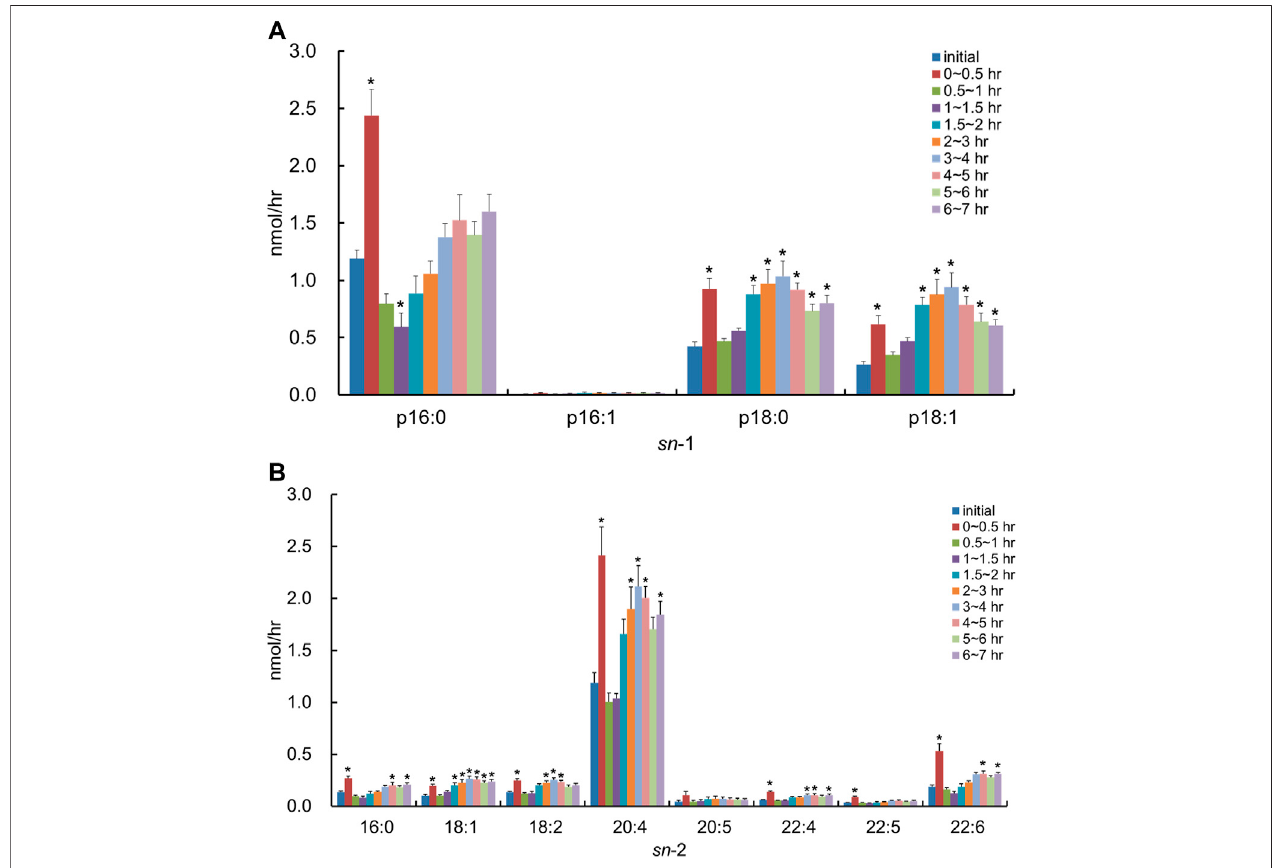
FIGURE 7 | Change in molecular species due to the classi fi cation in (A) the hydrocarbon chain at the sn -1 position and (B) FA at the sn -2 position in the lymphatic PlsChoofthoracic lymph-cannulatedratsfor7 hafter duodenaladministration oftheemulsion containingthelipidextracted fromporcine brain.Dataarerepresented as mean ± SEM ( n = 5 – 6). Asterisk indicates signi fi cant difference with respect to the values at time 0 ( p < 0.05).